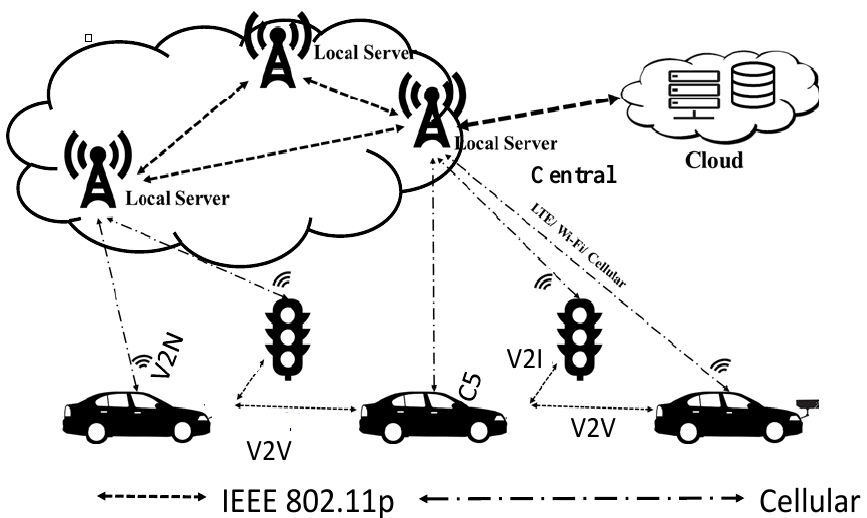
Figure 1. V2X communication